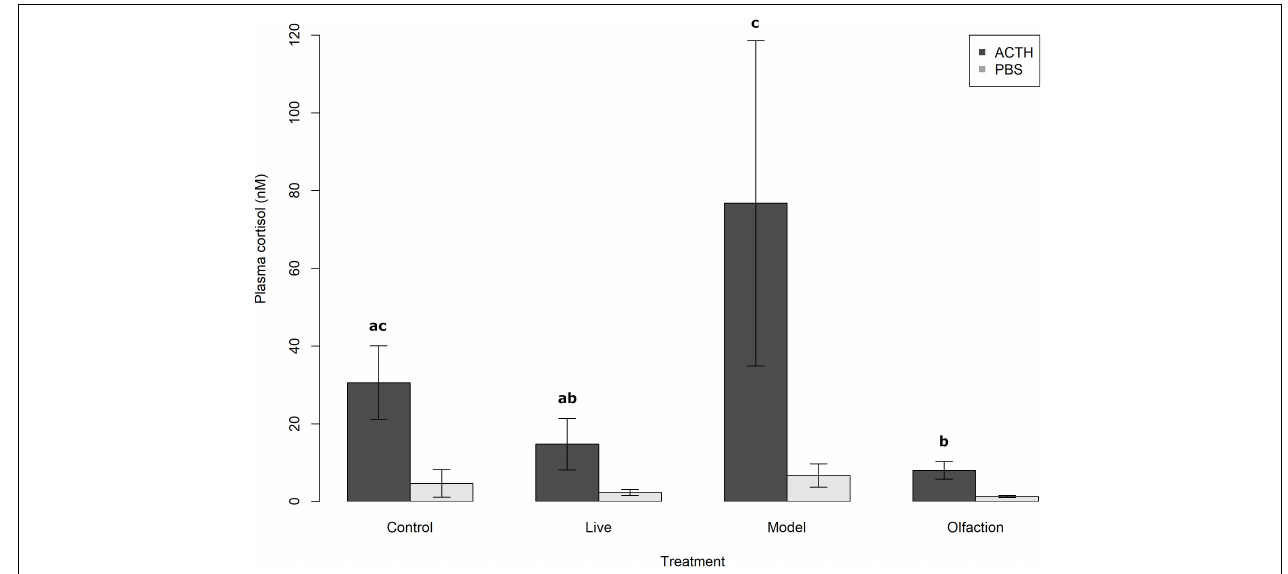
FIGURE 5 | Mean plasma cortisol (nM) levels with 95% confidence intervals in lumpfish ( n = 16) 2 h post-intraperitoneal injection with either 0.5 mL kg − 1 phosphate-buffered saline (PBS) or 45 µ g mL − 1 adrenocorticotropic hormone (ACTH). 24 h prior to sampling, lumpfish were injected with 1 mg kg −